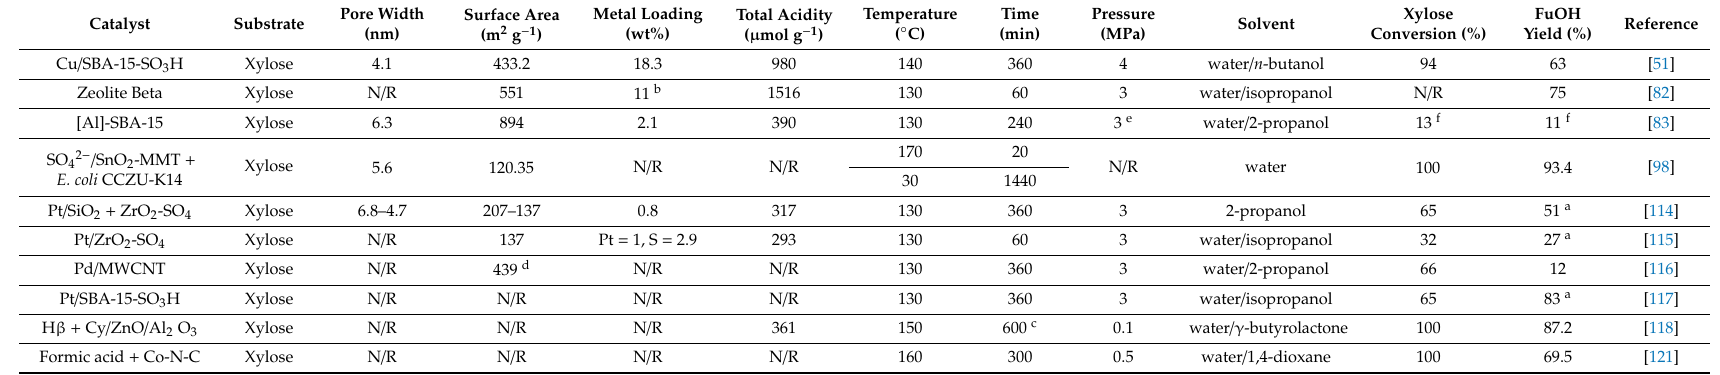
Table 2. Production of FuOH from